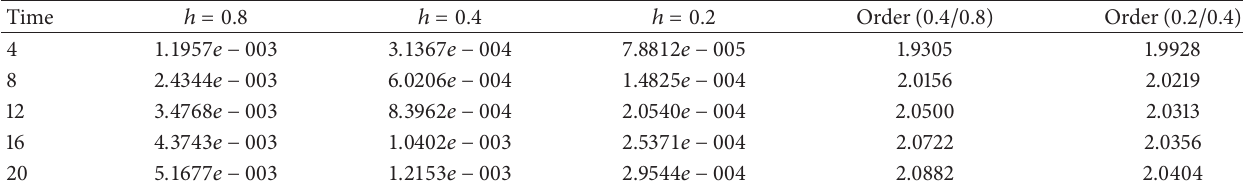
Table 9: Convergence order and error in 𝐿 ∞ norm for 𝑞 of space with Δ𝑡 = 0.01 and 𝑐 = 0.1 .